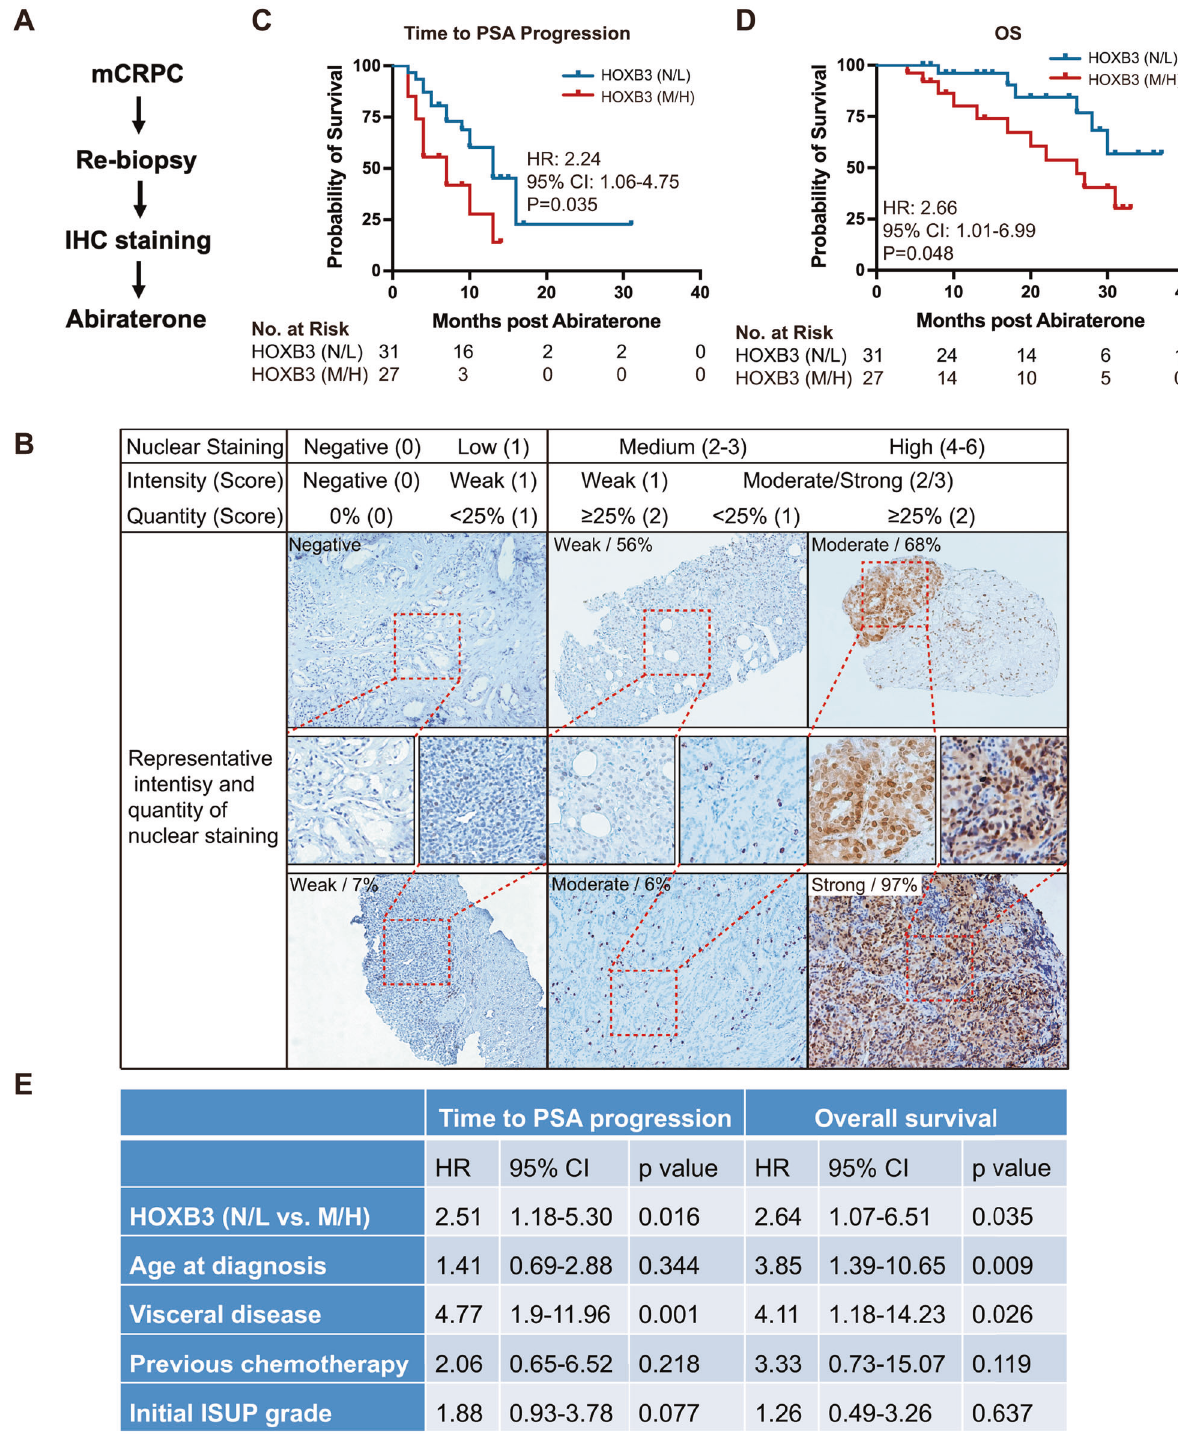
Fig. 1 HOXB3 expression is associated with resistance to abiraterone and poor outcome in mCRPC patients. A Flow chart of patients participating in this prospective cohort study. B Representative staining of HOXB3 in nuclear. Staining levels were classi fi ed as Negative or Low (N/L), Medium and High. C , D Kaplan – Meier curves of ( C ) time to PSA progression and ( D ) overall survival (OS) after abiraterone therapy in CRPC patients, by HOXB3 expression. E Multivariable logistic regression analyses of time to PSA progression and OS. IHC immunohistochemistry, CI con fi dence interval, HR hazard ratio, ISUP International Society of Urological Pathology Consensus Conference on Prostate Cancer Grading.